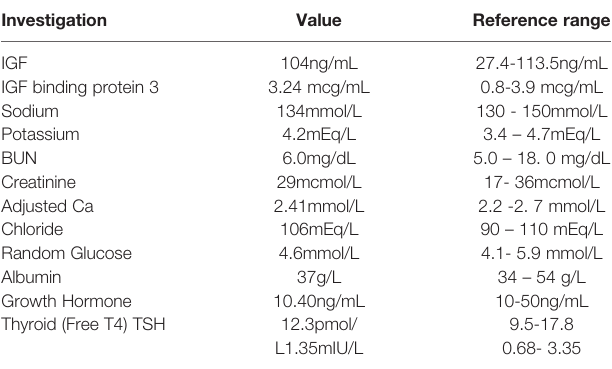
TABLE 1 | Biochemical measurements.